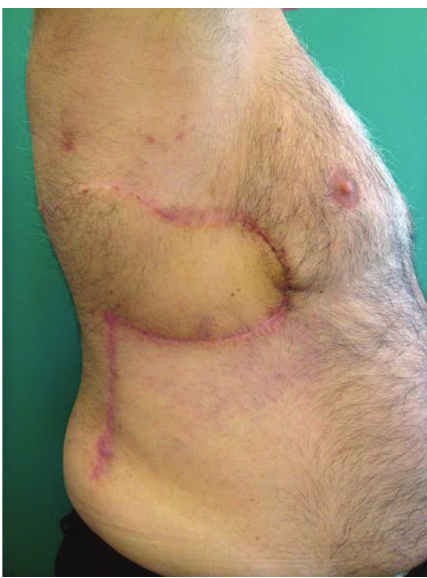
Figure 4: Wound healed after reconstruction of the defect with a latissimus dorsi transposition